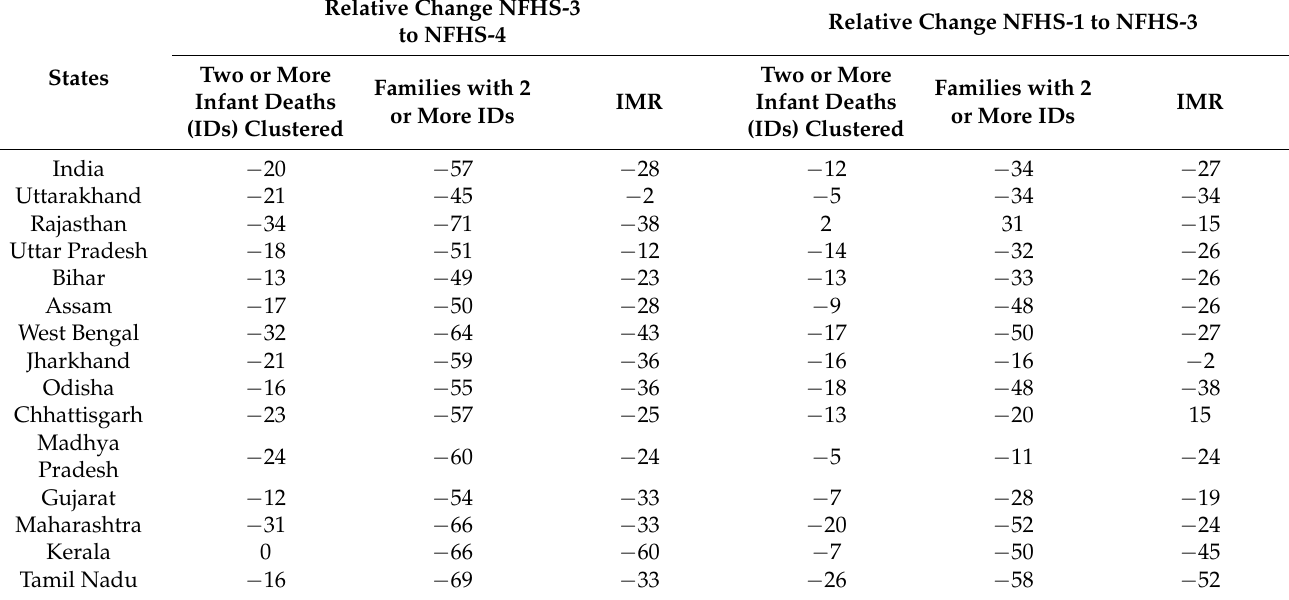
Table 2. Relative change in clustering of deaths in India and selected states,